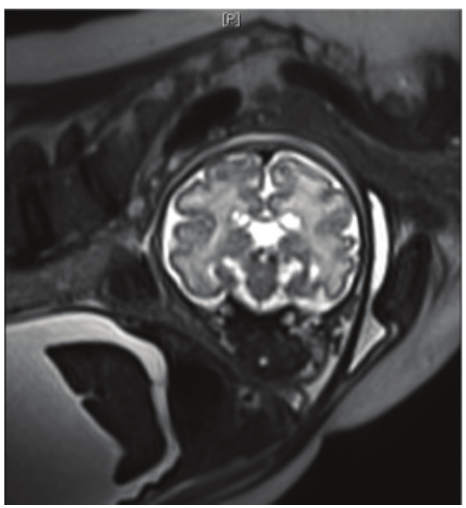
Figure 3: Cephalic antenatal fetal MRI. Coronal T2. Cysts of the caudate nuclei.